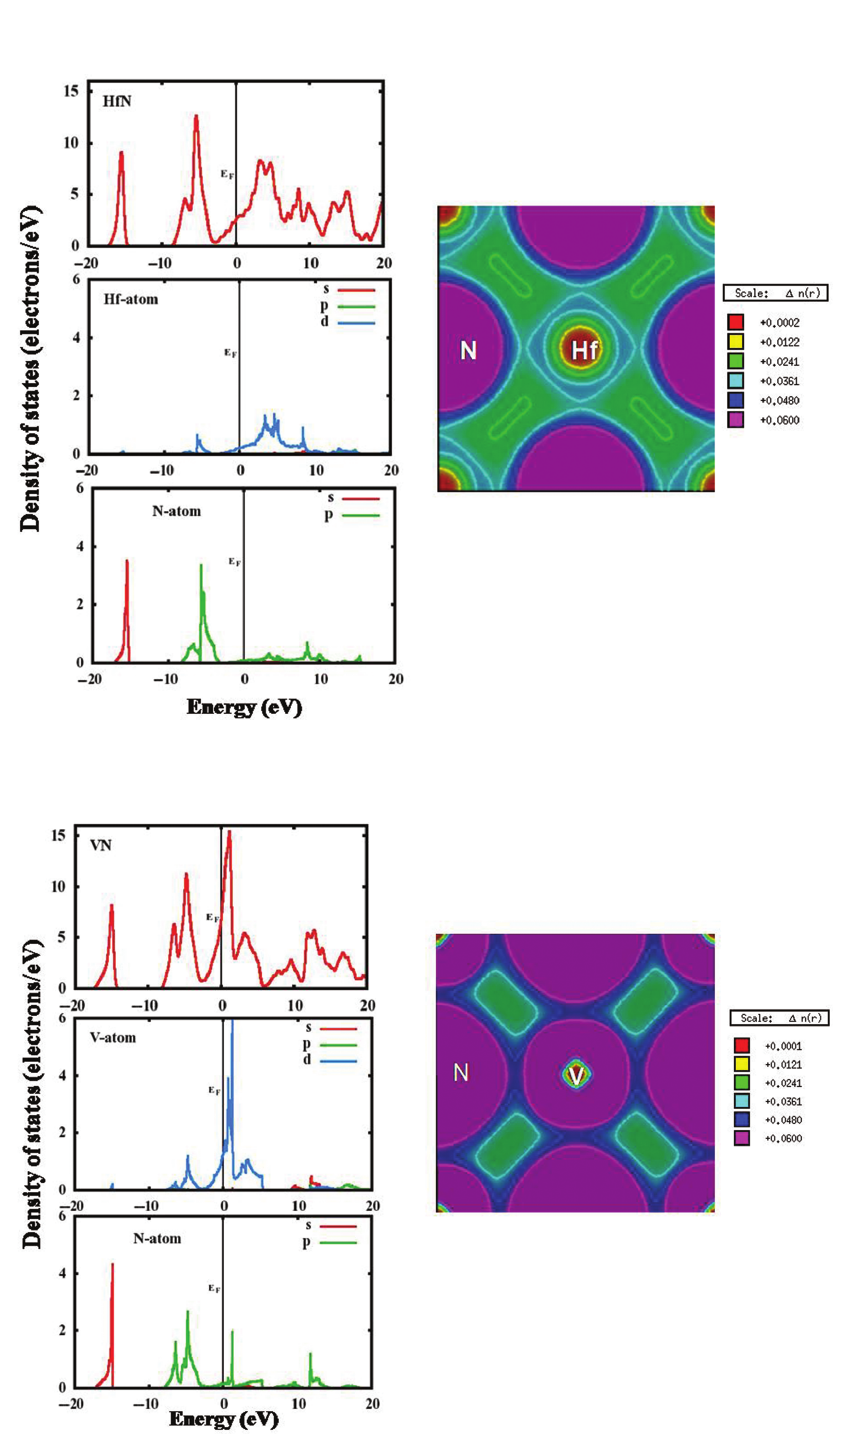
Figure 6: Electronic DOS and 2D charge density of